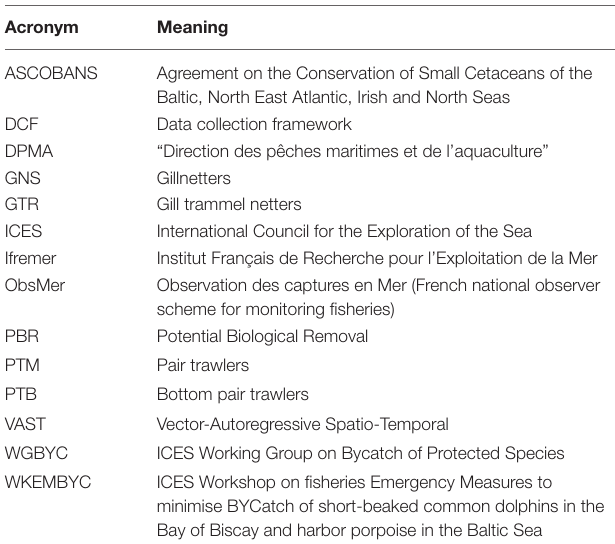
TABLE 1 | List of